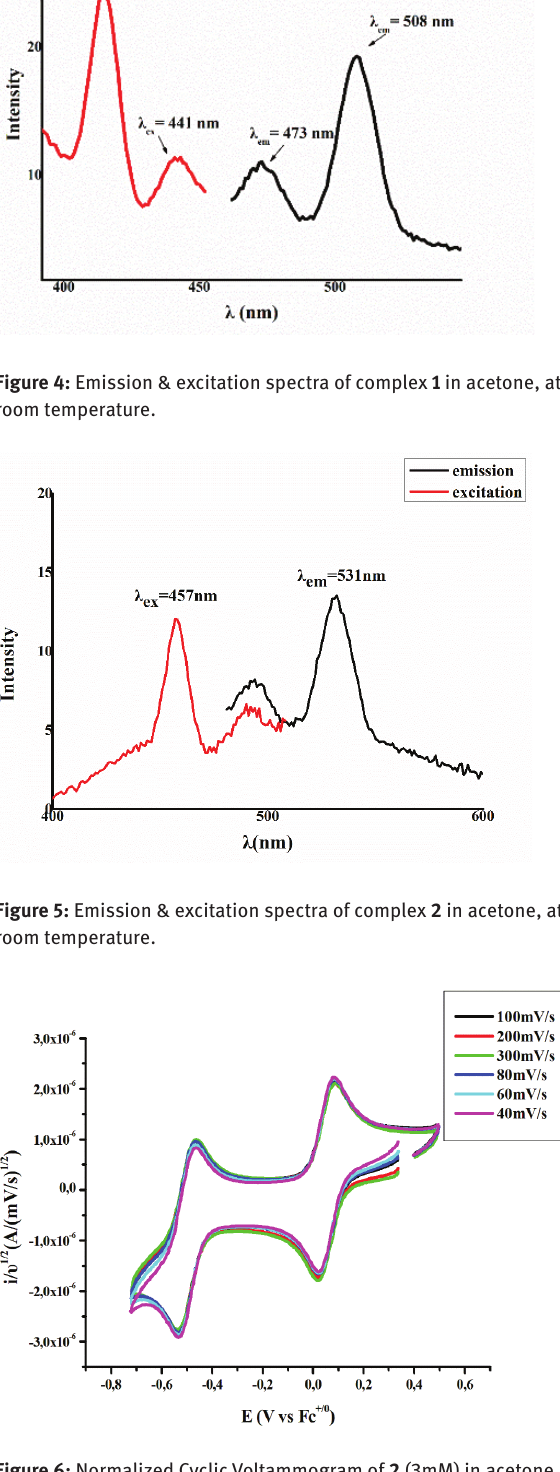
Figure 6: Normalized Cyclic Voltammogram of 2 (3mM) in acetone / 0,5 M n-Bu NPF . Working electrode: platinum disk (0,5 cm). Scan 4 6 rate: 300, 400, 100 ,60 and 40